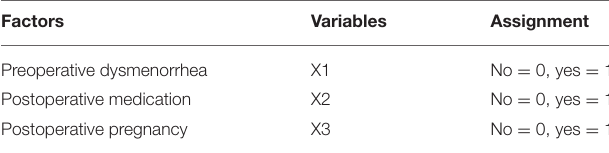
TABLE 2 | Assignment for multivariate logistic regression analysis. Factors Variables Assignment